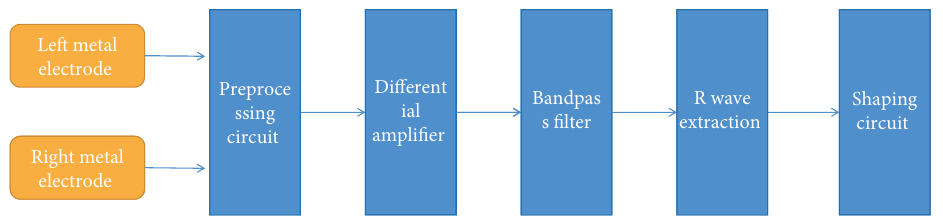
Figure 2: Block diagram of heart rate acquisition. Table 1: Heart rate prediction methods.